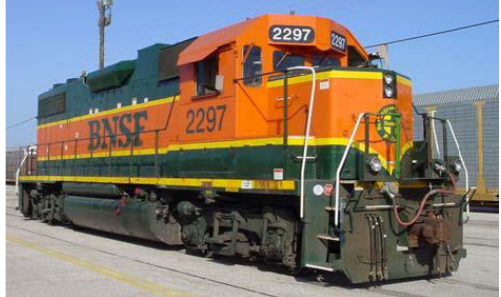
Fig. 1. EMD GP38-2 road-switcher locomotive